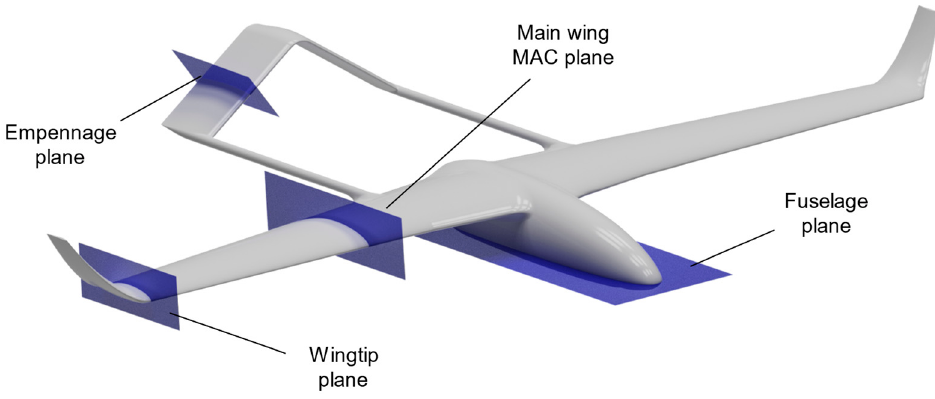
Figure 8. Planes on which boundary layer transition was investigated.